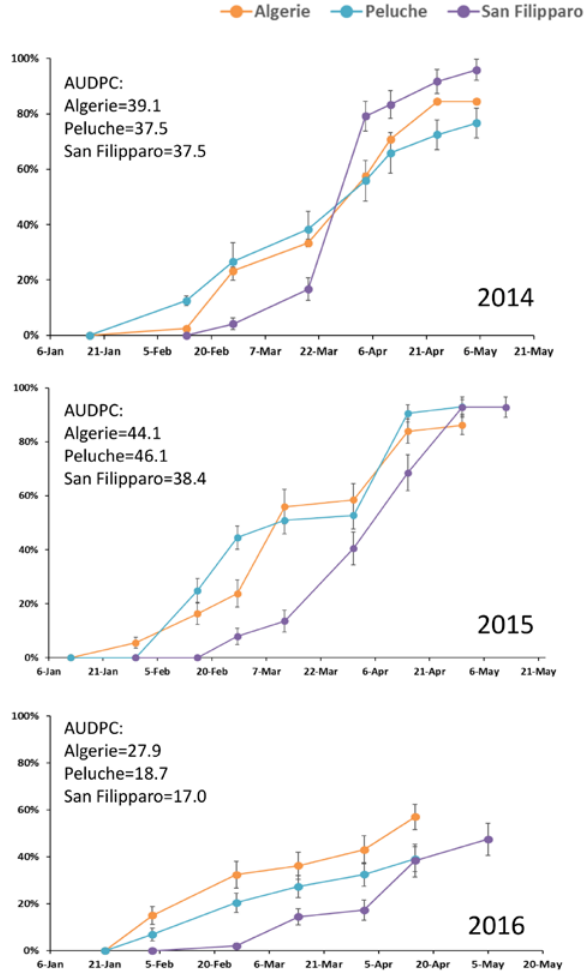
Figure 3. Mean percentages of loquat fruit affected by scab in three different cultivars and years. Whiskers indicate standard errors. Values of area under disease progress curve (AUDPC) are indicated for each cultivar and